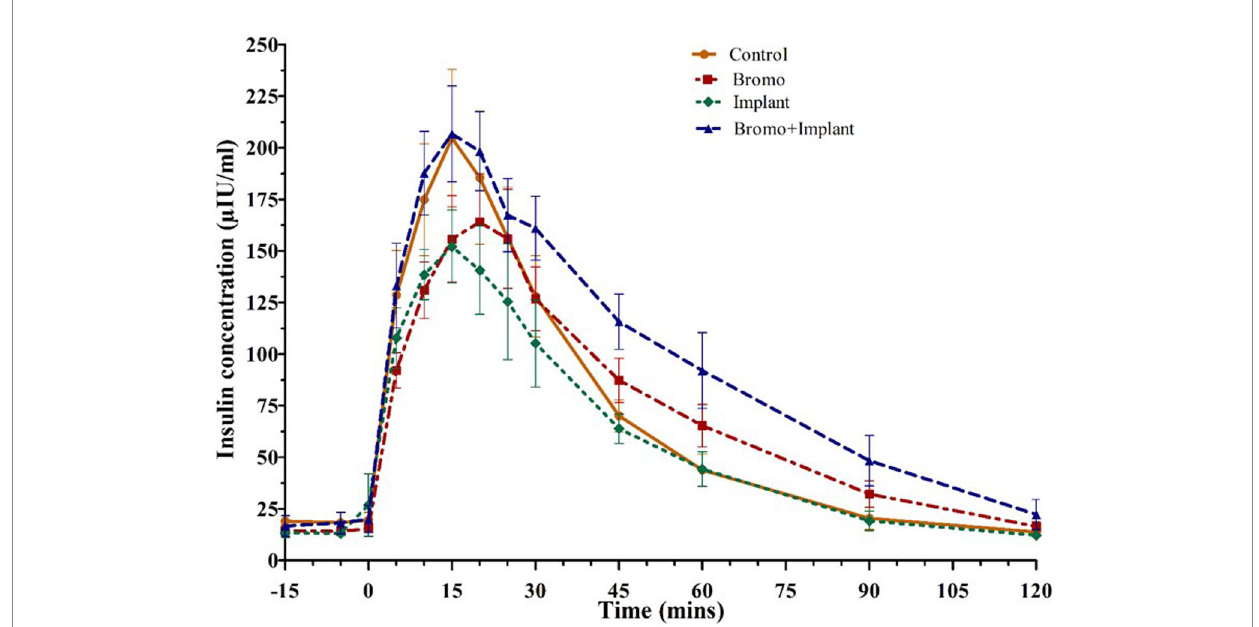
FIGURE 3 Mean plasma concentration of insulin (uIU/mL) Values are means ± SE of plasma insulin concentrations during intravenous glucose tolerance test (IVGTT) for steers treated with bromocriptine injections and estradiol implants performed on d 35. Used to determine area under the curve, peak height, and time to peak. Bromocriptine significantly increased AUC ( p = 0.04) and there was a trend ( p = 0.09) for it to increase time to peak. There was a significant bromo x implant interaction ( p = 0.07) which increased AUC and peak height. Time point 0 represents sample taken immediately before